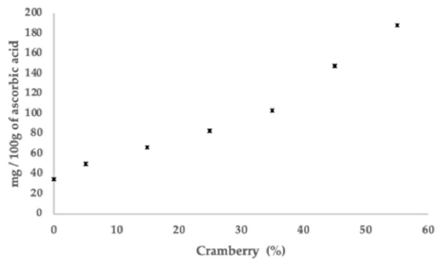
Figure 4. Ascorbic acid content of edible films from arrowroot starch and gelatin incorporated with